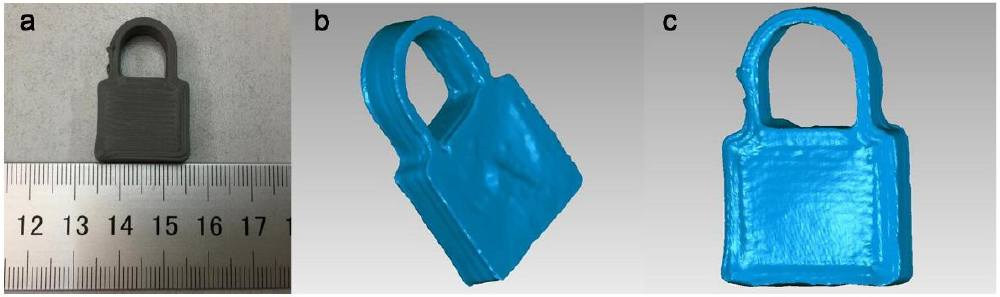
Figure 2. ( a ) 3D-printed Fe-based metallic glass part, reconstructed 3D models of ( b ) printed part and ( c ) sintered part.